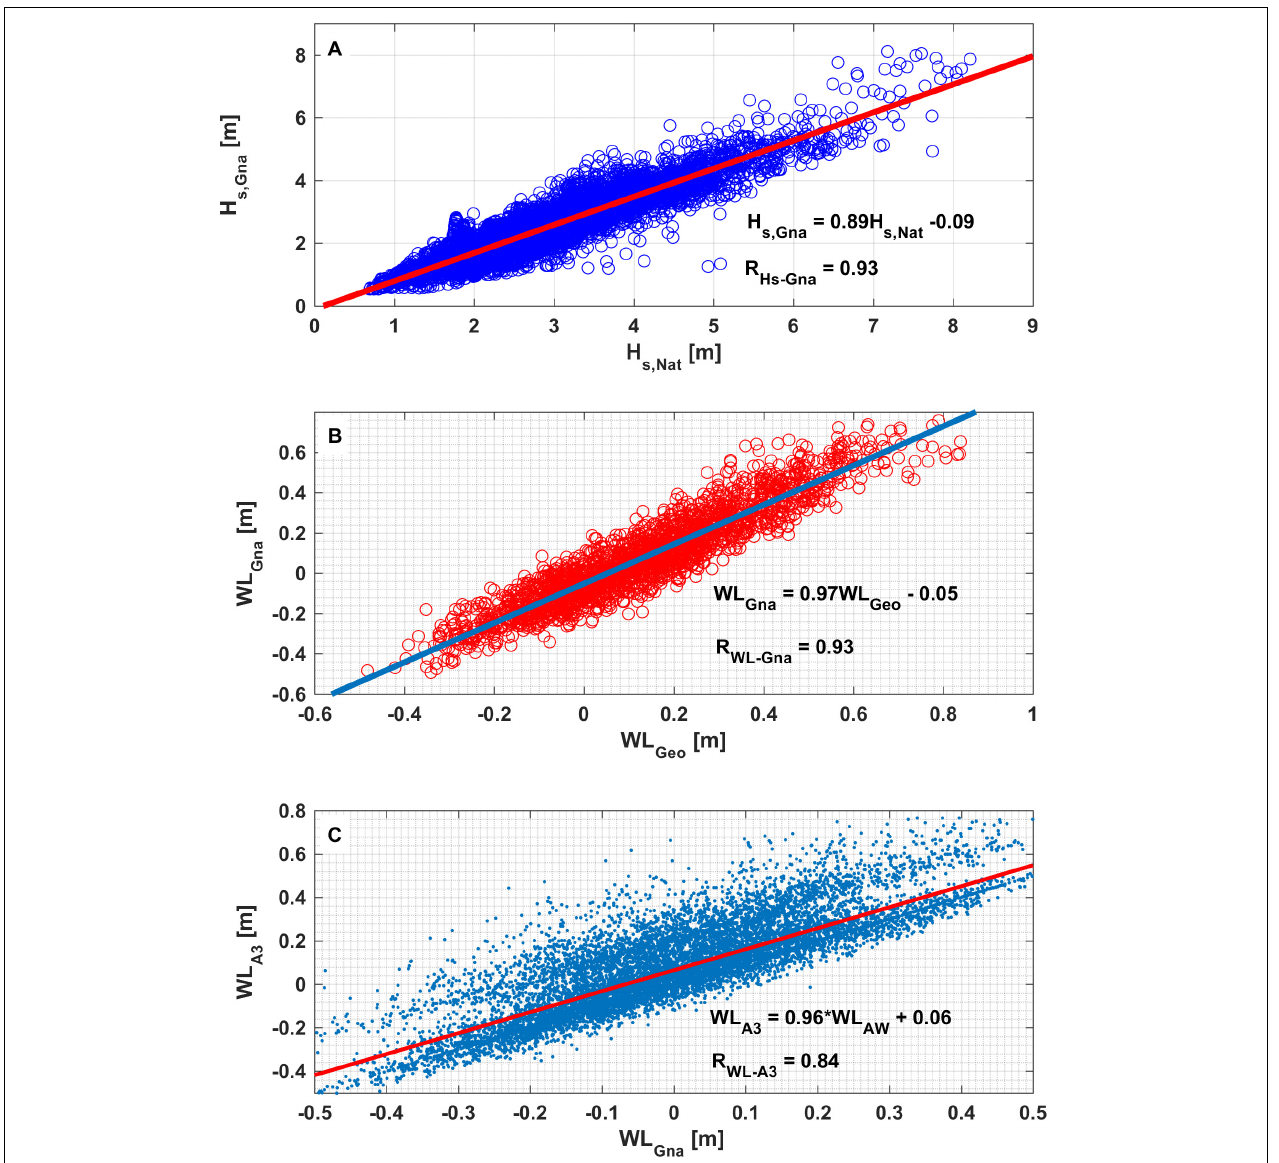
FIGURE 2 | Relationships between (A) offshore wave heights at Cape Naturaliste ( H Nat ) and Gnarabup ( H Gna ), (B) offshore water level elevations at Busselton ( WL Bus ) and Gnarabup beach ( WL Gna ), and (C) offshore water level at Gnarabup beach (from AWAC and Busselton tide station) and inside the lagoon at